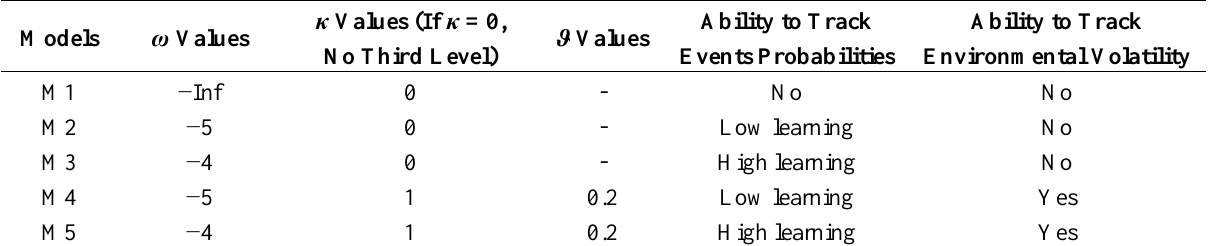
Table 1. Five alternative models used and compared in